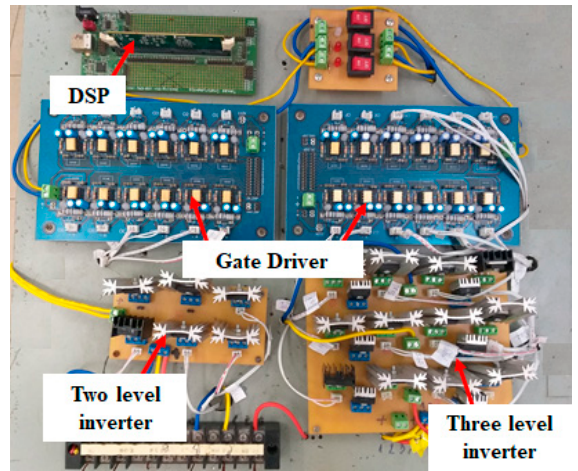
Figure 8. Experimental setup of the prototype.